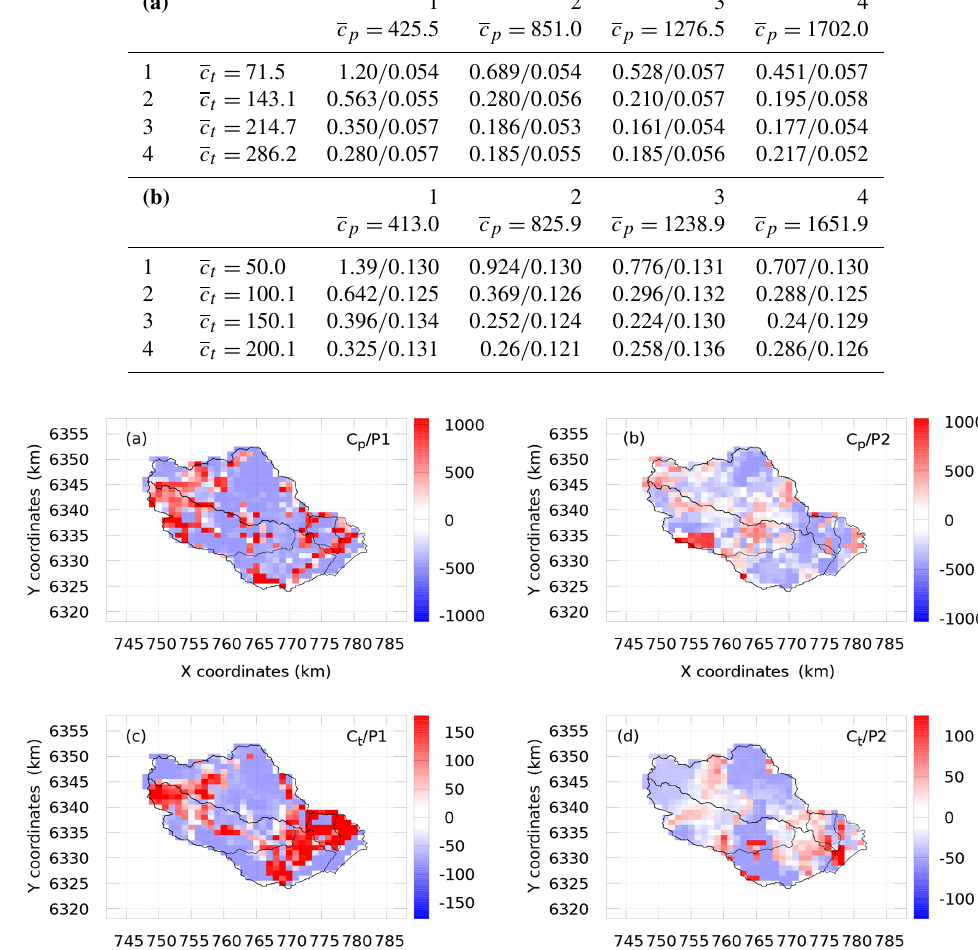
Figure 8. Maps of stability measure σ θ for c p (a, b) and c t (c, d) , for periods P 1 (a, c) and P 2 (b,